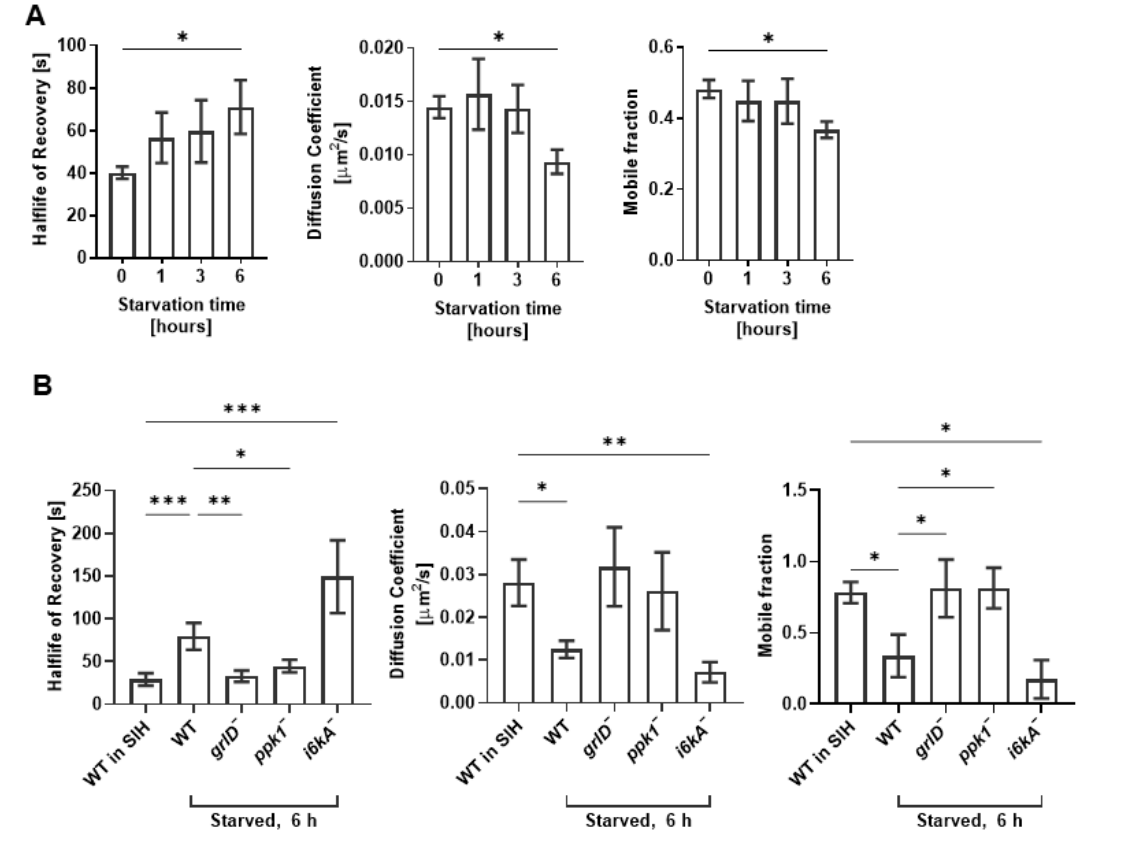
Figure 3. Starvation reduces cell membrane fluidity of WT and i6kA − cells. ( A , B ) Half ‐ life of recovery, diffusion coefficient, and mobile fraction were calculated from fluorescence recovery after photobleaching of WT cells starved in PBM for 0, 1, 3 and 6 h ( A ) and WT cells incubated in SIH for 0 h or WT, grlD − , ppk1 − , and i6kA − cells starved in PBM for 6 h ( B ). Values are mean ± SEM of 3 independent experiments. * p < 0.05, ** p < 0.01, *** p < 0.001 (One ‐ way ANOVA with Brown ‐ Forsythe and Welch test).